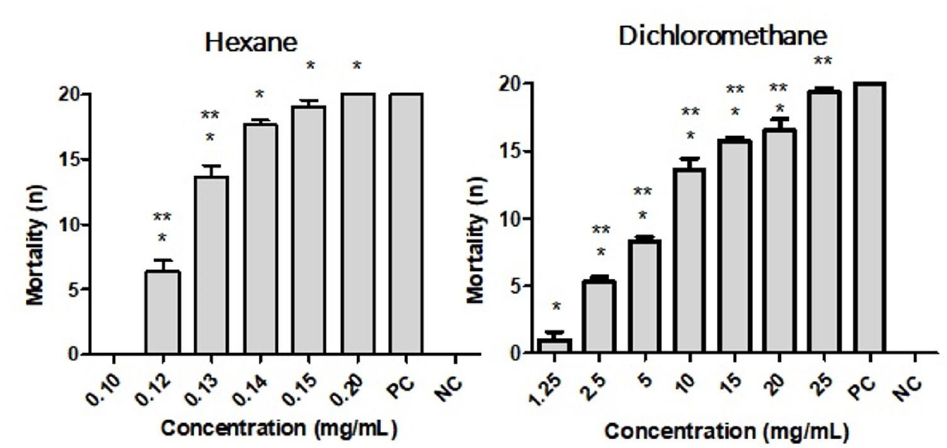
Figure 3. Pupicidal activity of different concentrations of fractions of Helicteres velutina on Aedes aegypti pupae after 72 hours. PC = Positive Control, NC = Negative Control (*) Results significantly different from negative control. (**) Results significantly different from positive